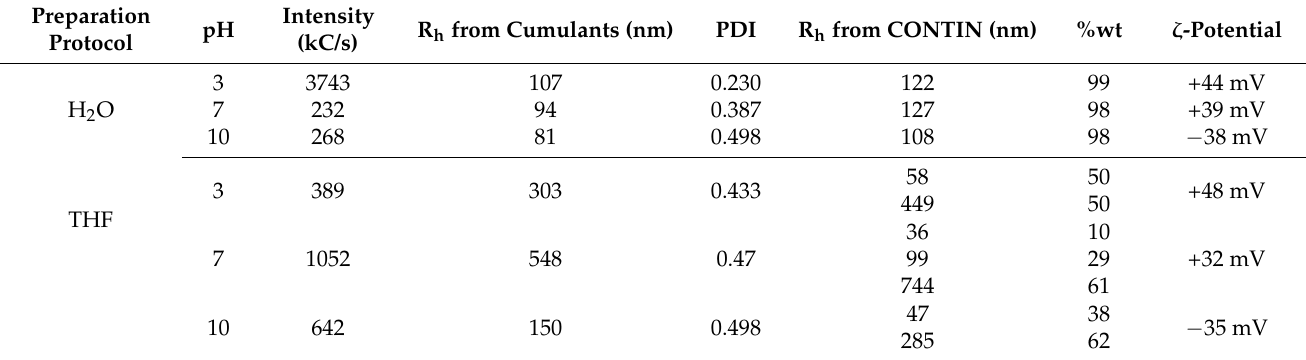
Table 5. Effect of pH on the properties of copolymer PQFD 20% aqueous solutions . Preparation Protocol